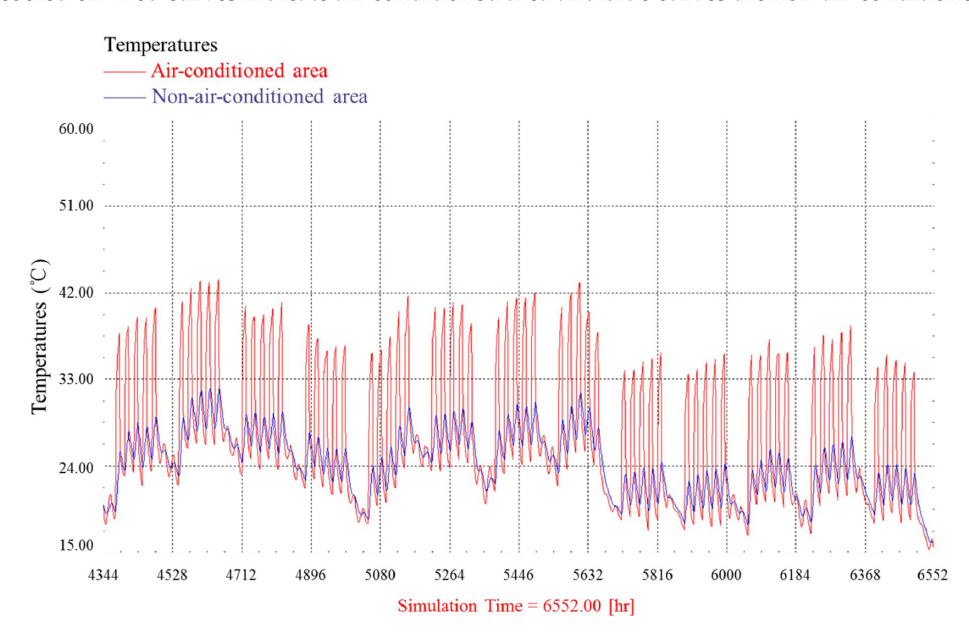
Figure 3. Temperature temporary change without cooling.